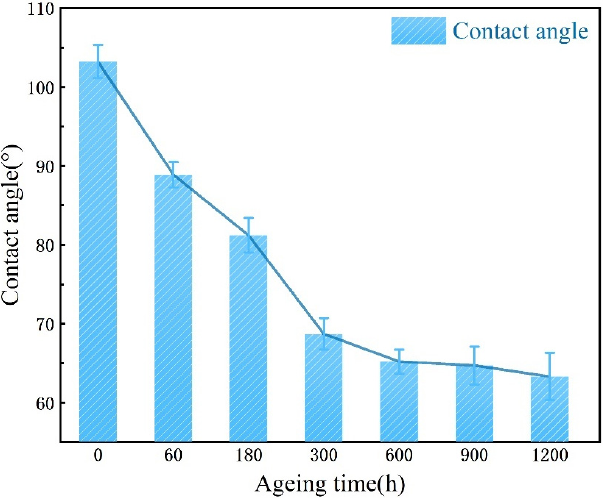
Figure 11. Relationship between contact angle and ageing time of epoxy resin coating.